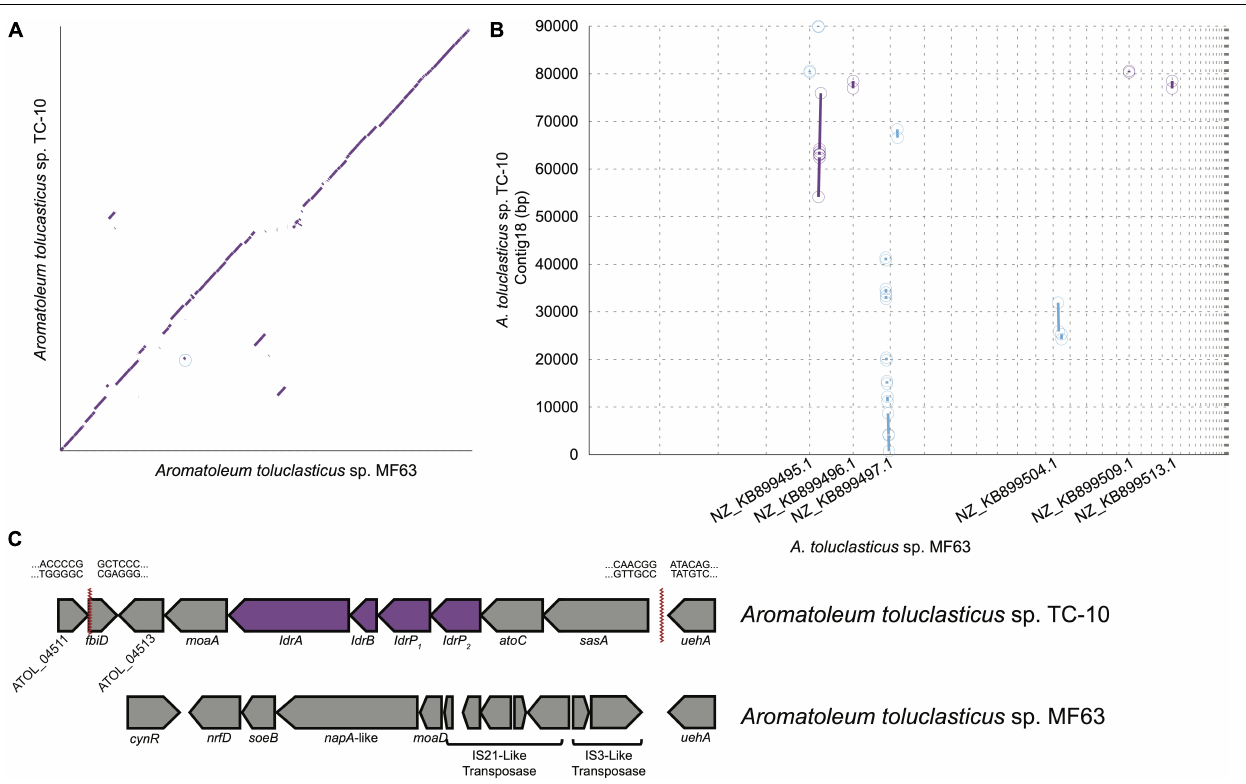
FIGURE 2 | (A) A synteny plot showing regions of major synteny, weak synteny, and gaps between Aromatoleum toluclasticum MF63 and TC-10. (B) A synteny plot showing the regions of conservation along node 18 in TC-10, which contains the IRI. The gap between 41,363 and 54,119 bp signifies the region containing the IRI. (C) The IRI in TC-10 with catalytic idr genes is denoted by the purple color. Red serrated lines denote borders of the IRI. Sequences flanking serrated lines represent the nucleotide sequence at either side of the IRI border. MF63 is provided below as a comparison to demonstrate the lack of the IRI near uehA